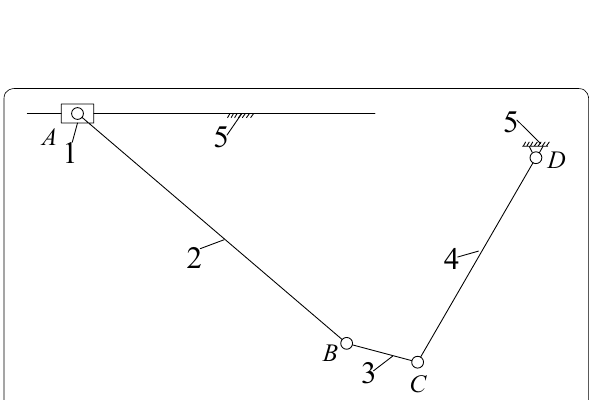
Figure 13 Source metamorphic mechanism for the repositioning machine